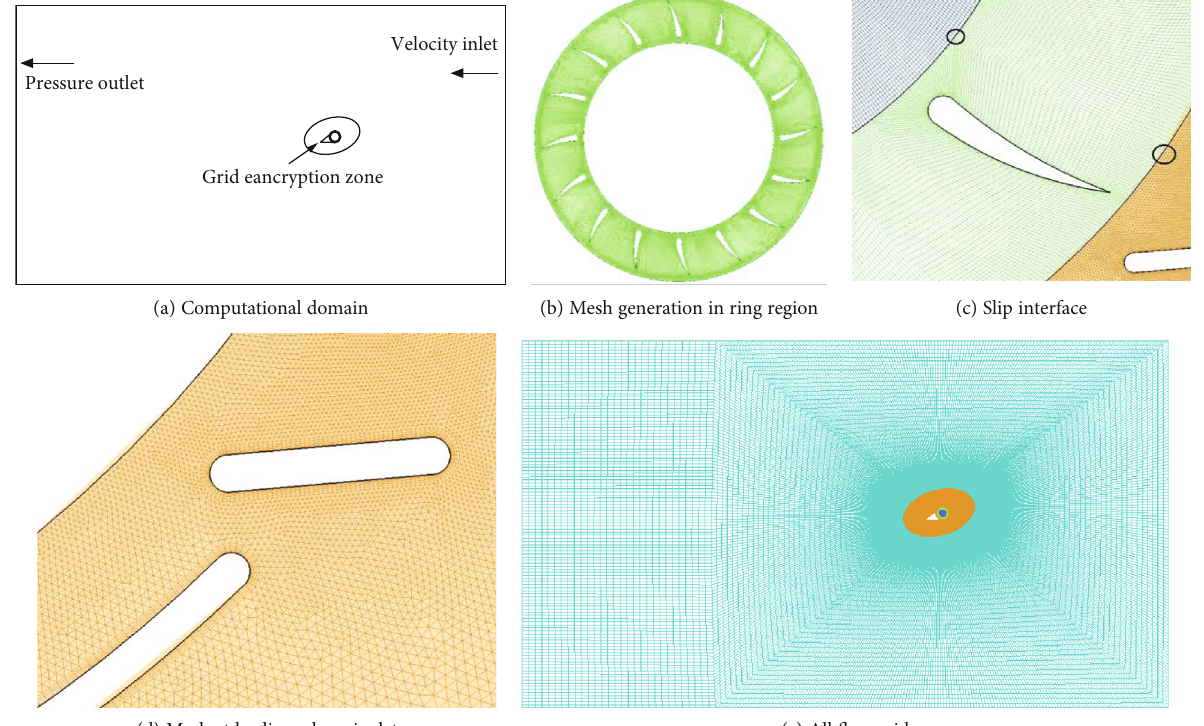
Figure 4: Mesh generation.